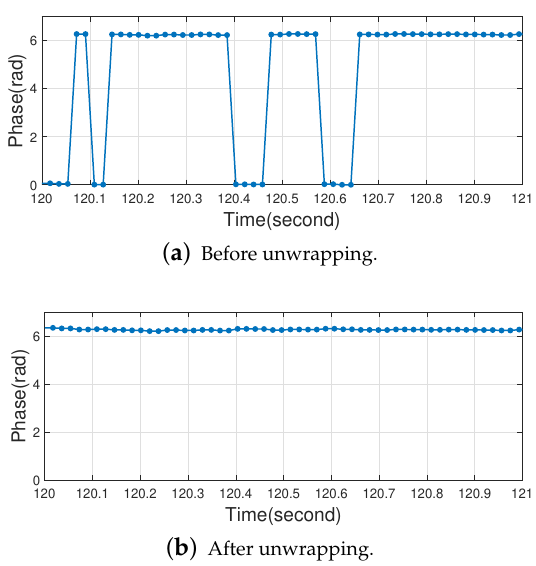
Figure 8. Phase data before and after phase